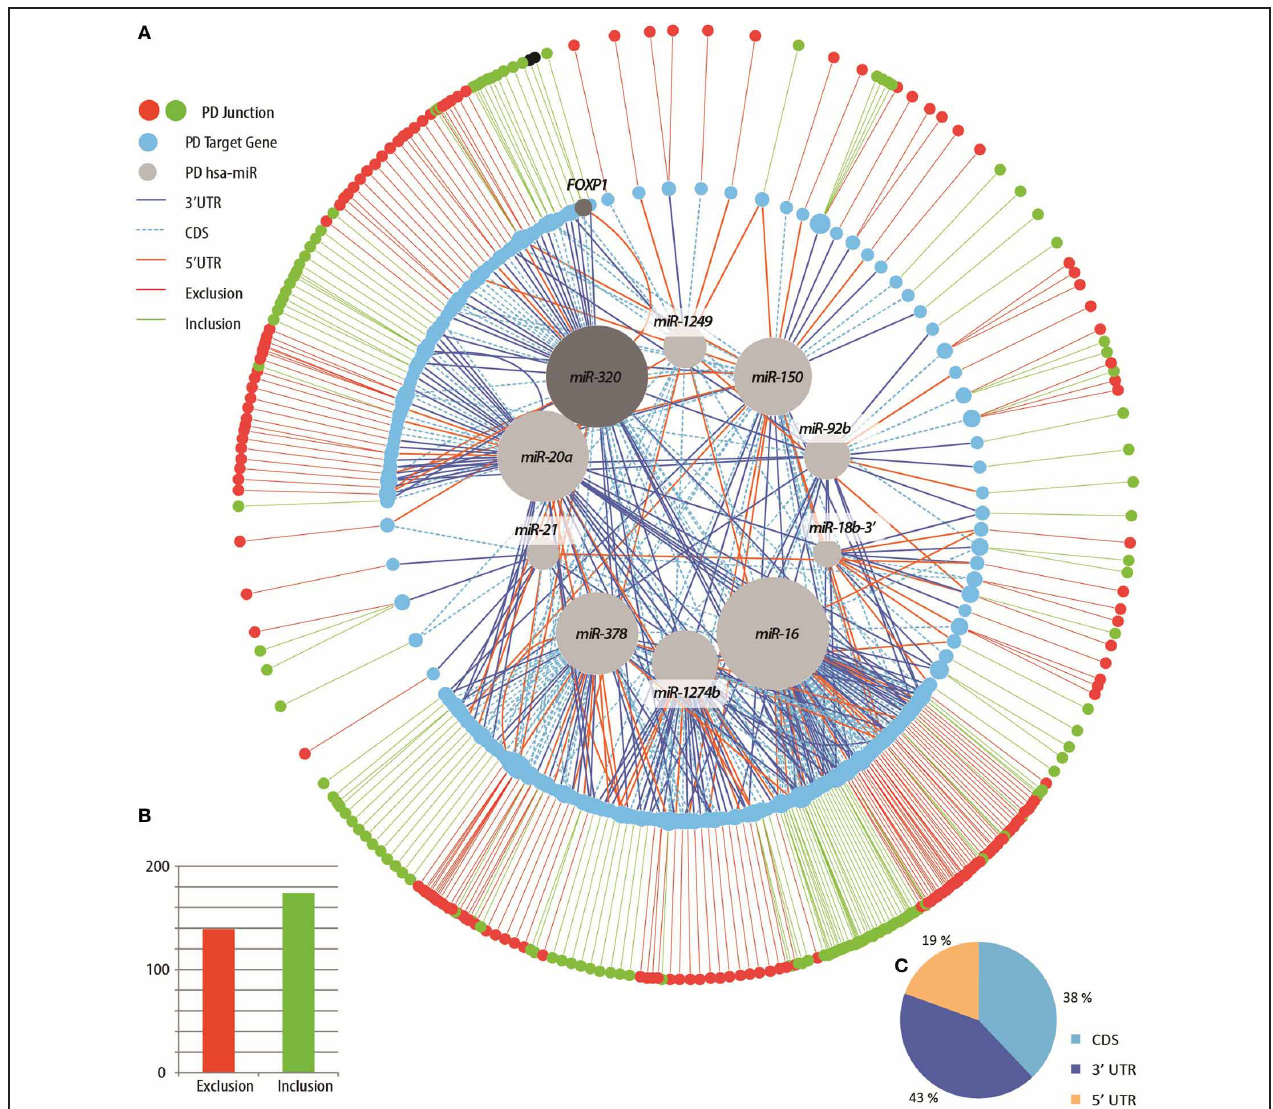
sequence, CDS). Middle circle: the predicted target genes. Gray circle color highlights miRNAs targeting the PD-related gene FOXP1 , previously linked to miRNA regulation. Curved lines in the inner circle denote two different regions predicted to be bound (e.g., 3 (cid:2) UTR and coding sequence). (B) PD patients exhibited more inclusion events (green) as compared with exclusion (red). (C) The types of events predicted to be regulated by the changed miRNAs: 3 (cid:2) un-translated region (UTR) (dark blue), 5 (cid:2) UTR (orange) or coding sequence (CDS, light